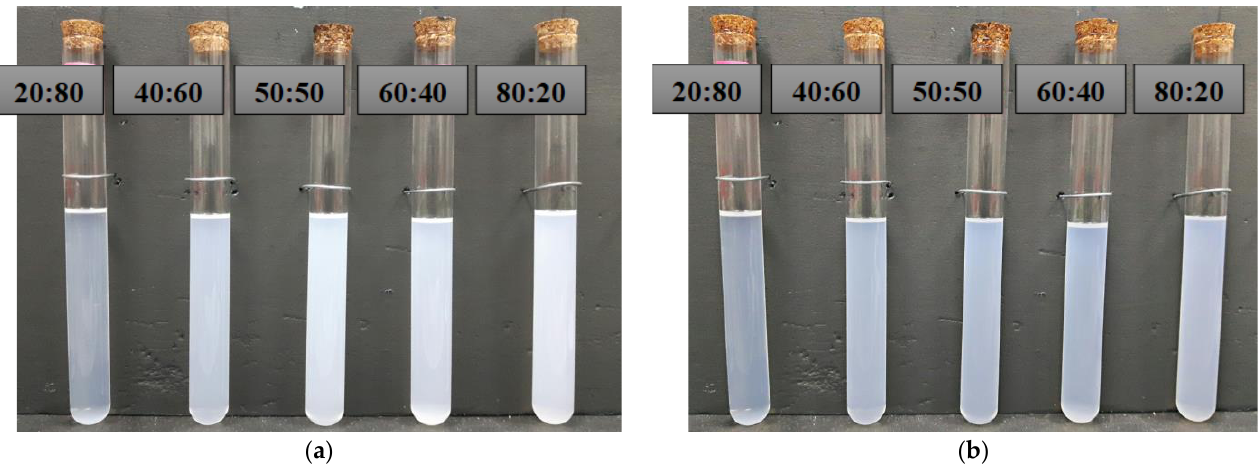
Figure 2. Samples of the Al 2 O 3 -SiO 2 /PAG hybrid nanolubricant after 30 days: ( a ) After preparation; ( b ) after 30 days of preparation.